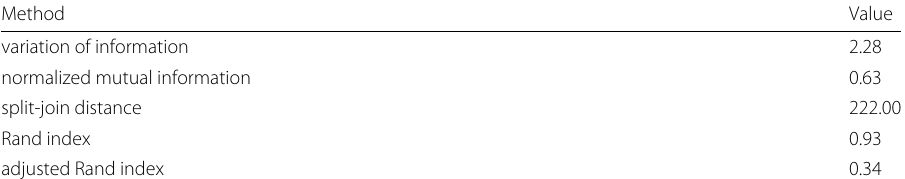
Table 5 Comparison of modular structures detected using the Infomap algorithm Main vs Rewired